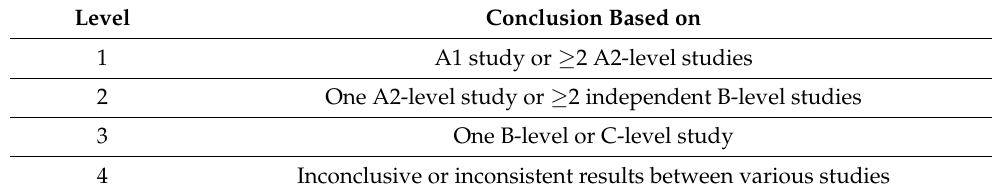
Table 2. Strength of Conclusion.